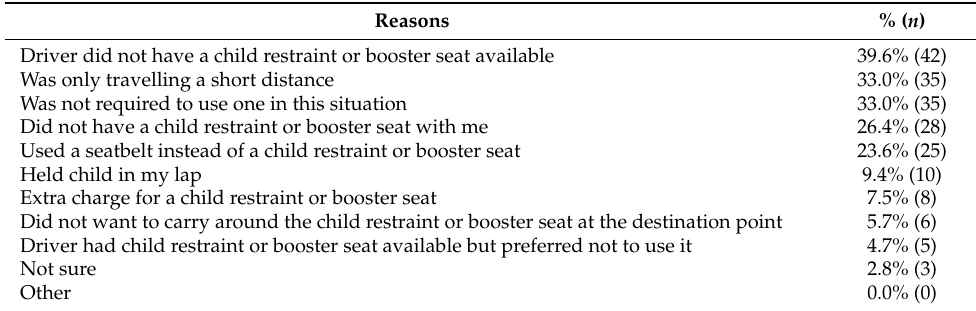
Table 8. Participants’ reasons for not ‘always’ using an appropriate restraint in a rideshare vehicle with their youngest child ( n = 106).